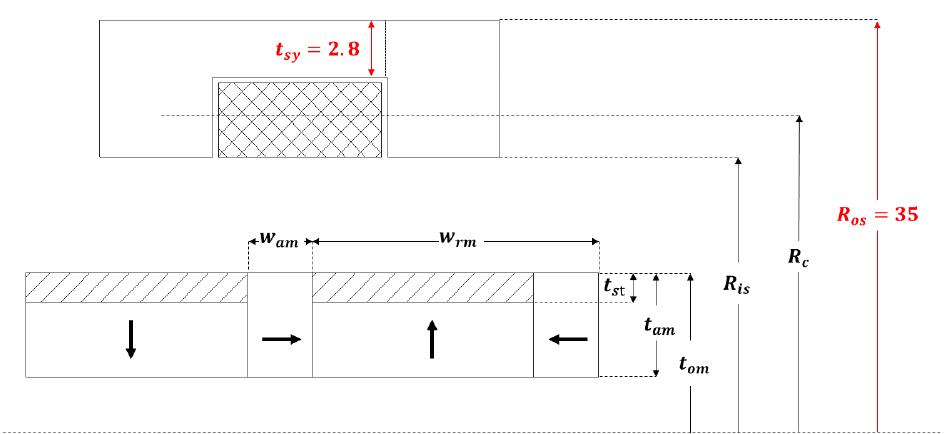
Figure 4. Design parameter of EHSA with the stator outer radius R os and stator yoke thickness t sy is fixed.